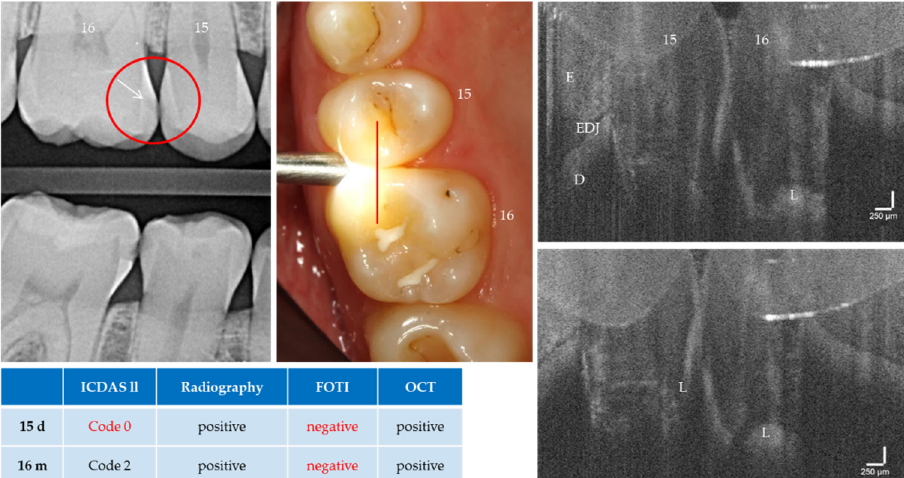
Figure 9. Teeth 44 (distal) and 45 (mesial). Detection of approximal caries lesions (L) with visual inspection, bitewing radiology, FOTI and OCT. The distal surface of tooth 44 was assessed as carious by all methods (arrows, L). In contrast, tooth 45 mesially was assessed as being sound with FOTI. In the OCT cross ‐ sectional images the carious lesions are clearly visible on both teeth. Tooth 44 (ROI) shows no dentin involvement in the upper OCT image, whereas this can be suspected in the lower image. Both tooth surfaces showed no cavitation even with variable positioning of the OCT probe. As a result of focusing on deeper structures, the tooth surface has flipped in the OCT images. Enamel (E), dentin (D), enamel ‐ dentin junction (EDJ). The vertical scales are related to the refractive index n = 1.0 (see remark in Figure 4).